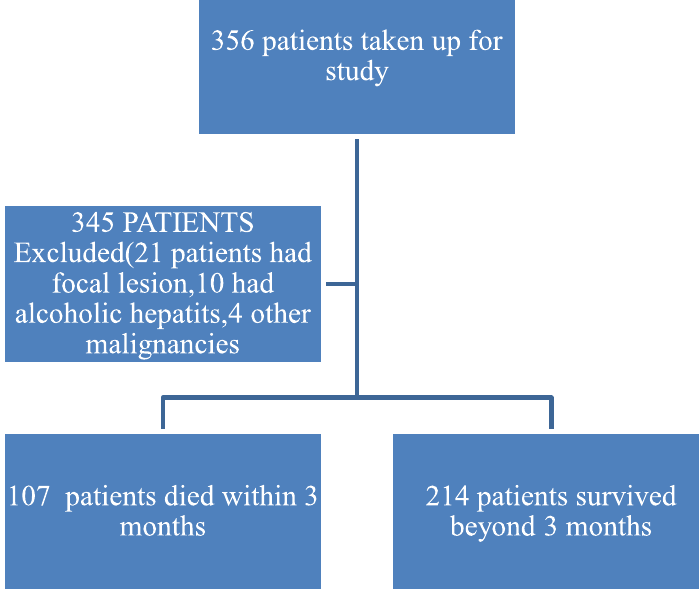
Fig. 1 Consort diagram of the test group